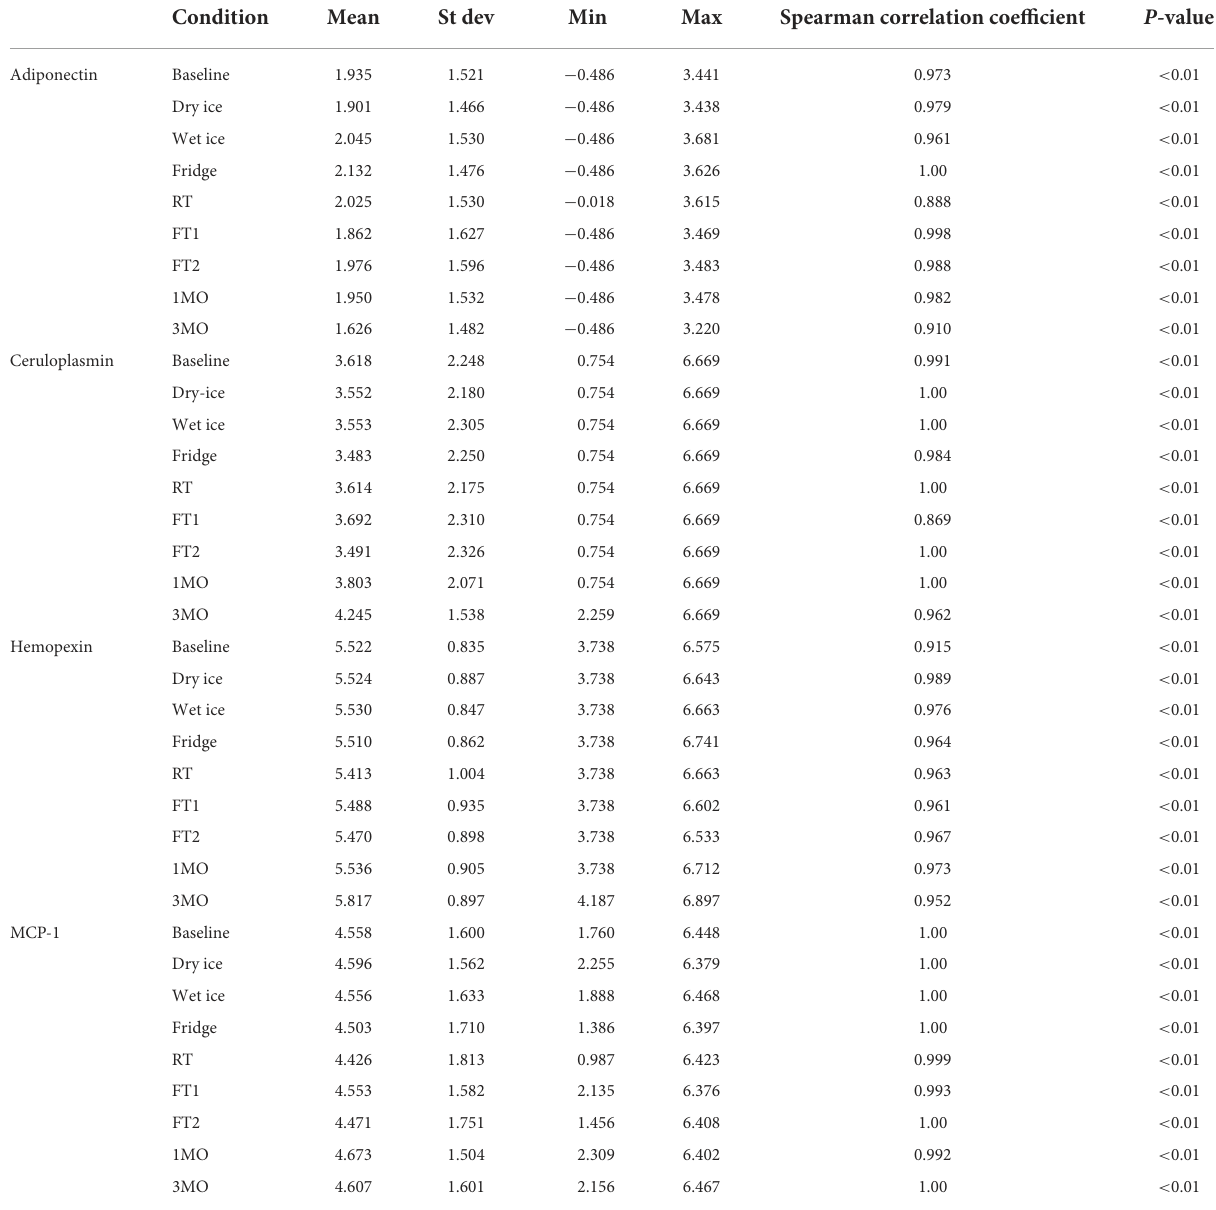
TABLE 1 Average urinary biomarker concentration under each experimental condition with spearman correlation coefficients. Condition Mean St dev Min Max Spearman correlation coefficient P